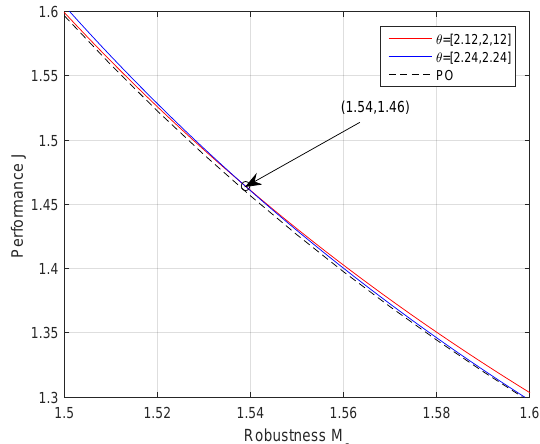
Figure 3: Reference Example: Performance vs. ro- bustness, J vs. M s trade-off curves. Com- paring settings, ˆ θ = [2 . 12 , 2 . 12], and ˆ θ ∗ = [2 . 24 , 2 . 24] vs. the PO curve.